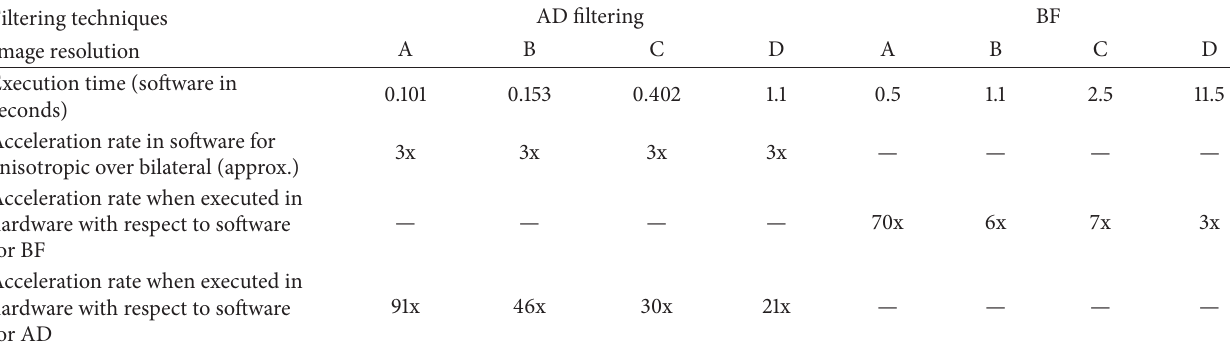
Table 5: Runtime comparison in software and hardware for bilateral filtering (BF) and anisotropic diffusion (AD) filtering (note that A = 150 × 150, B = 256 × 256, C = 512 × 512, and D = 1024 × 1024). The processing platform was done on an Intel(R) Core(TM) 2 Duo CPU T6600